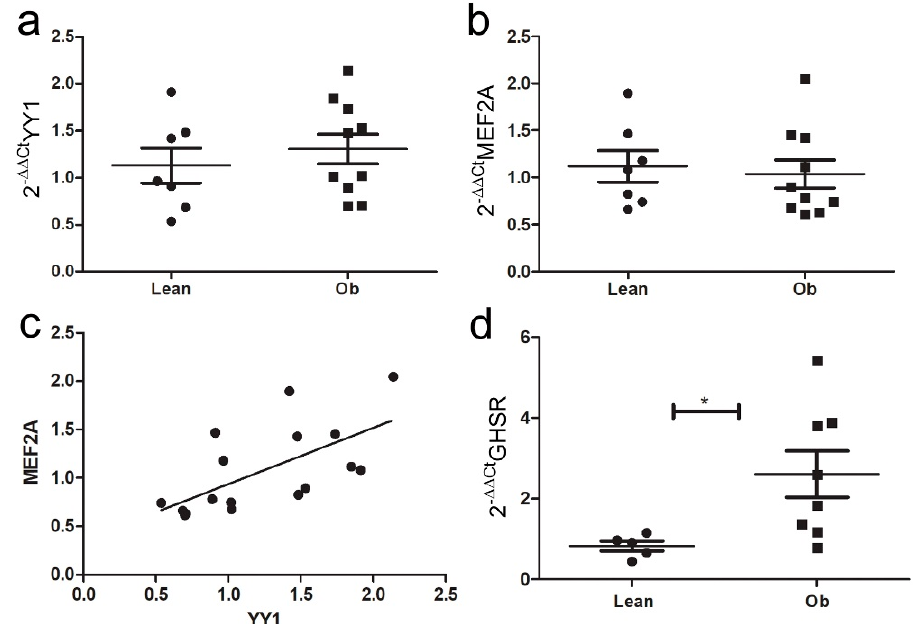
Figure 8. Ghrelin-induced pathway analysis in ZR cardiac biopsies. Graphs showed qPCR of ( a ) YY1 and ( b ) MEF2A expression in cardiac biopsies of ZR: ( c ) a positive correlation was observed between MEF2A and YY1 in cardiac biopsies of ZR. ( d ) GHSR mRNA was greatly increased in vivo in obese ZR (* p < 0.05). Student’s t -test: * p < 0.05. Full square stands for Obese rats, while full circle stands for Lean rats